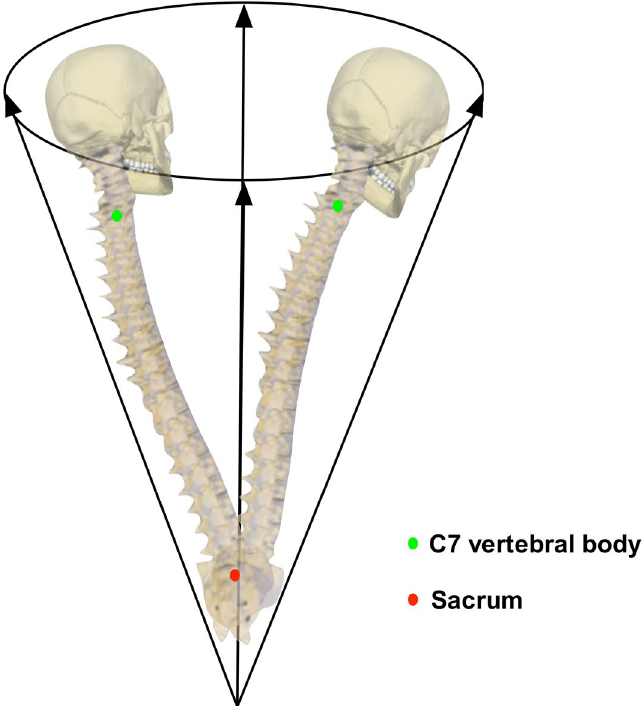
Figure 7. A diagrammatic representation of the ‘variability of the coronal and sagittal offset’ as described in this